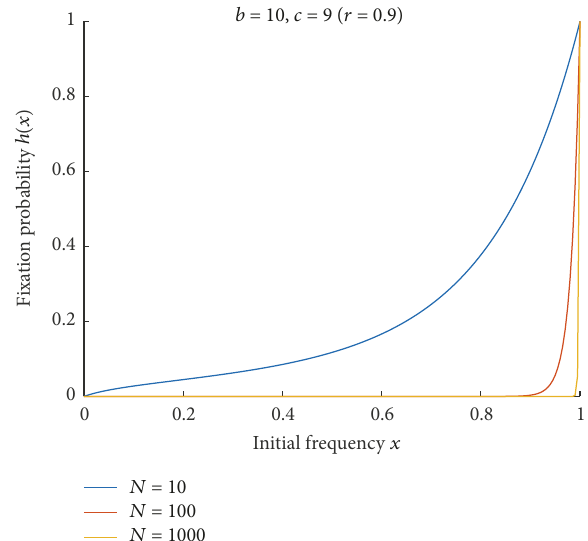
Figure 3: The plot of ℎ(𝑥) . When 𝑟 = 0.9 , which is above 𝑟 ∗ , the probability that cooperators will fix is negligible, regardless of the starting frequency of cooperators, as group size increases.